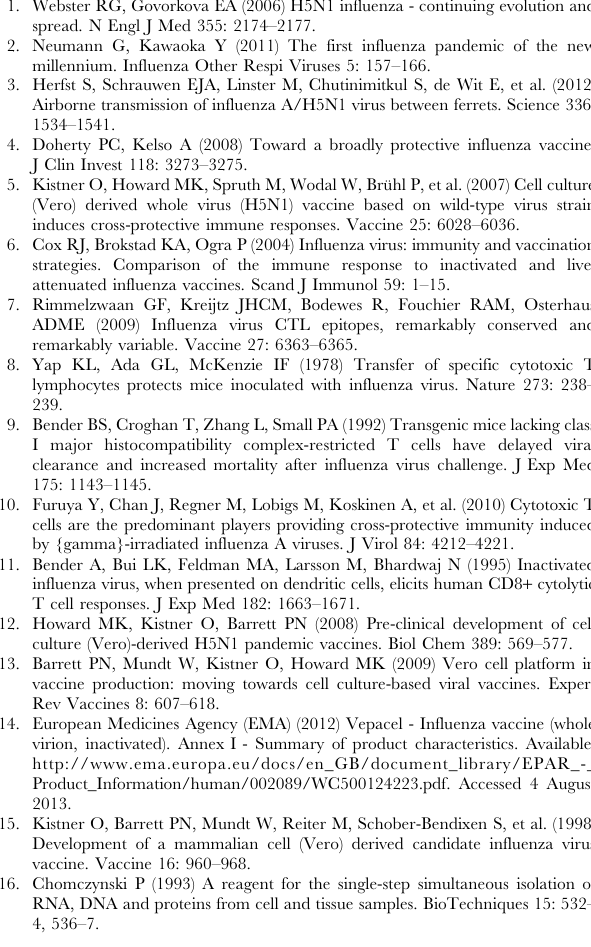
marked in red color, and nucleoprotein (NP) of H3N2 in green color, respectively. (TIF) Figure S5 Particles from avian A/H5N1-Vietnam whole virus vaccine can be detected in the cytosol. Similar to Figure 4, immature DC were incubated with whole virus vaccine of avian strain A/H5N1-Vietnam (VNw) for 2 h, processed and analyzed by TEM. Elongate particles of the whole virus vaccine presumably escaping the endolysosomal compartment, as well as particles localized within the cytosol can be observed. The white arrow in the upper left picture demonstrates the localization of the focused endolysosome within the DC.